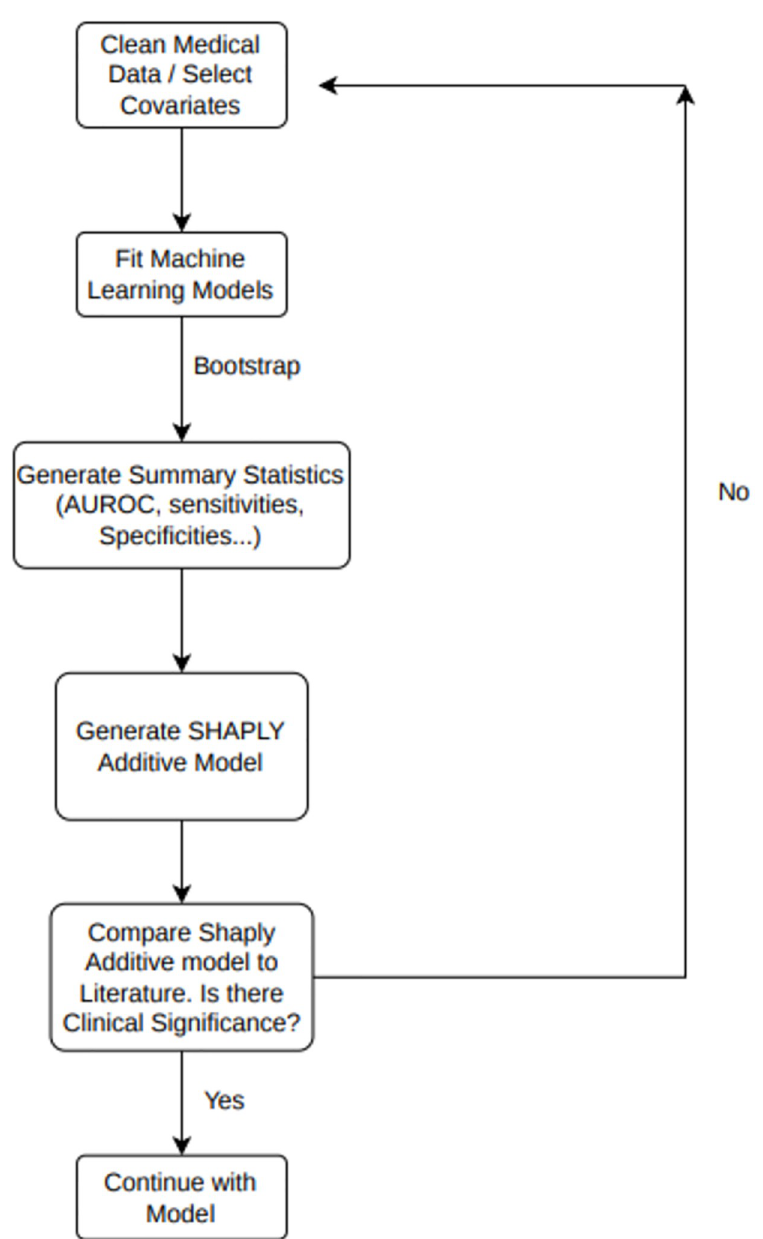
Fig 1. Consort flow diagram of machine learning workflow. Description of the overall workflow for machine- learning implementation described within study, starting with a cleaned dataset and ending with a final usable model after critical evaluation of model metrics and visualization of the model through